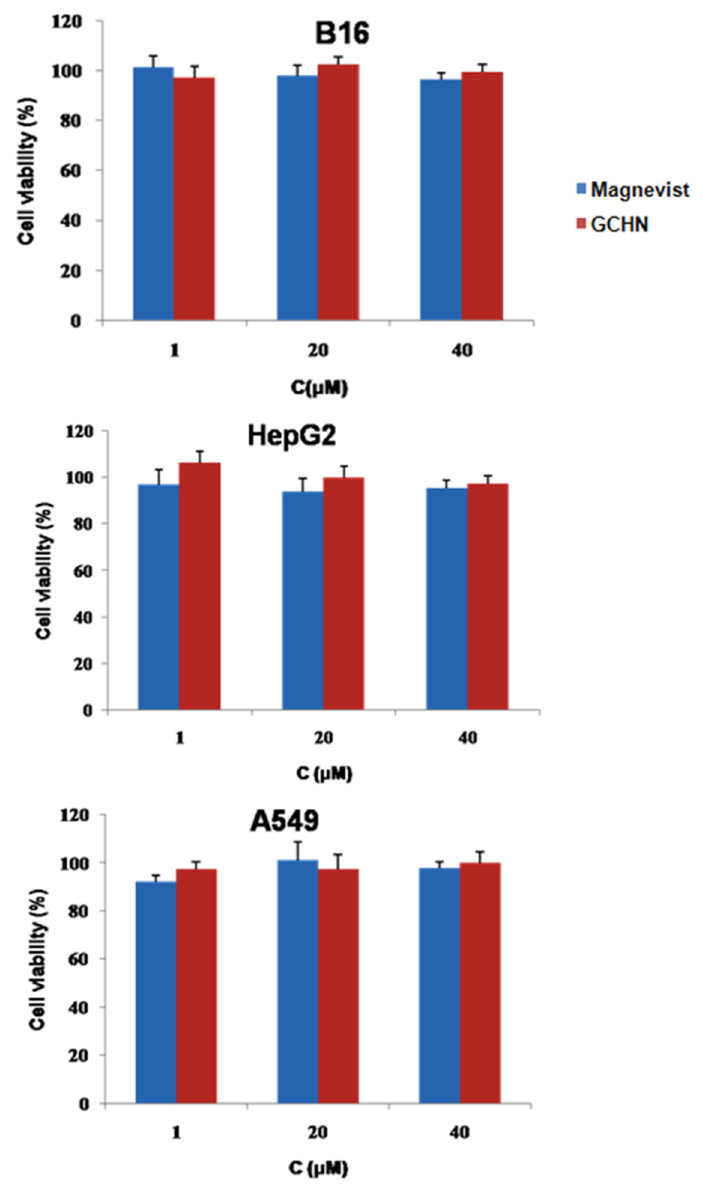
Figure 5. In vitro cytotoxicity results of Magnevist and